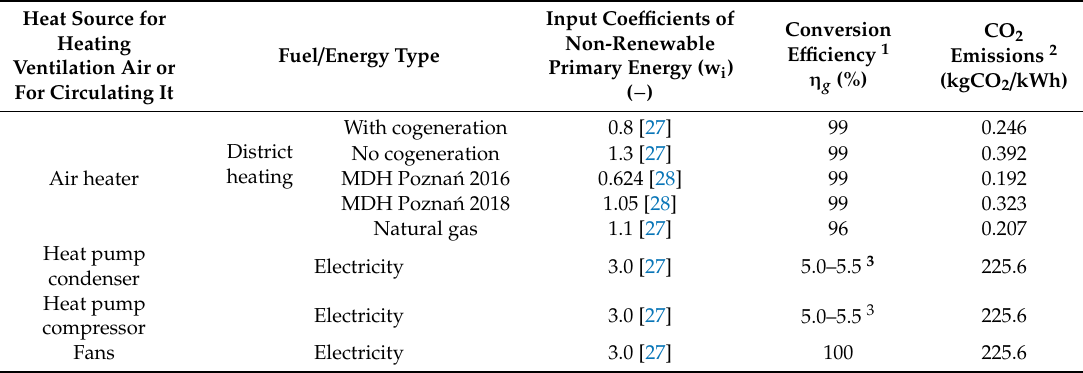
Table 1. Input coe ffi cients of non-renewable primary energy (w i ), conversion e ffi ciency η g and the CO 2 emissions for selected sources for heating ventilation air and pool